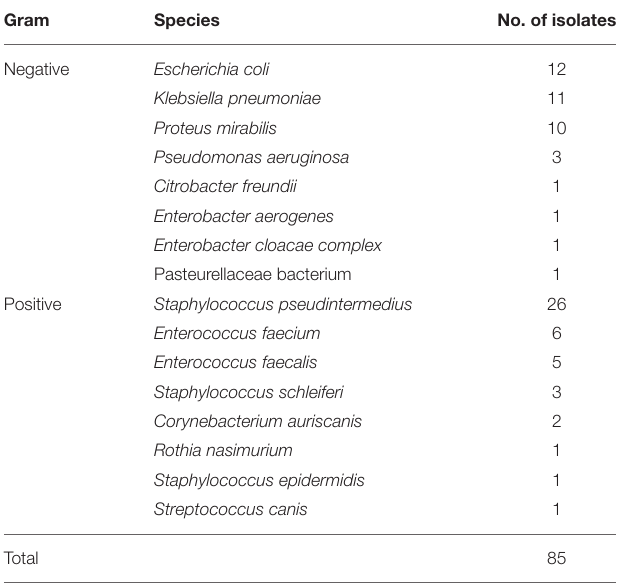
TABLE 2 | Species distribution of potential pan-drug-resistant isolates tested in this